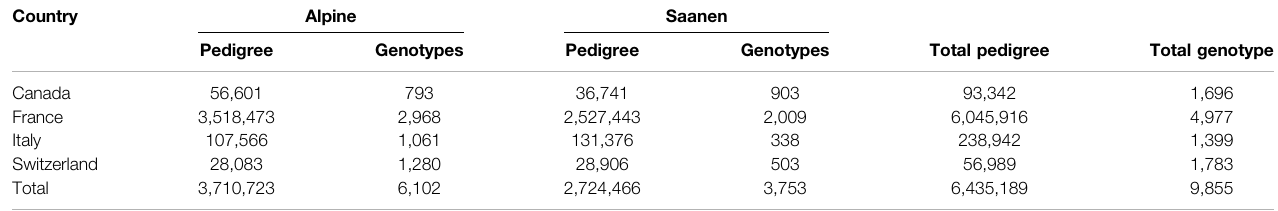
TABLE 1 | Number of animals after the quality control, per breed (Alpine and Saanen), included in the pedigree and genotype fi les shared by each country (Canada, France, Italy, and Switzerland). Country Alpine